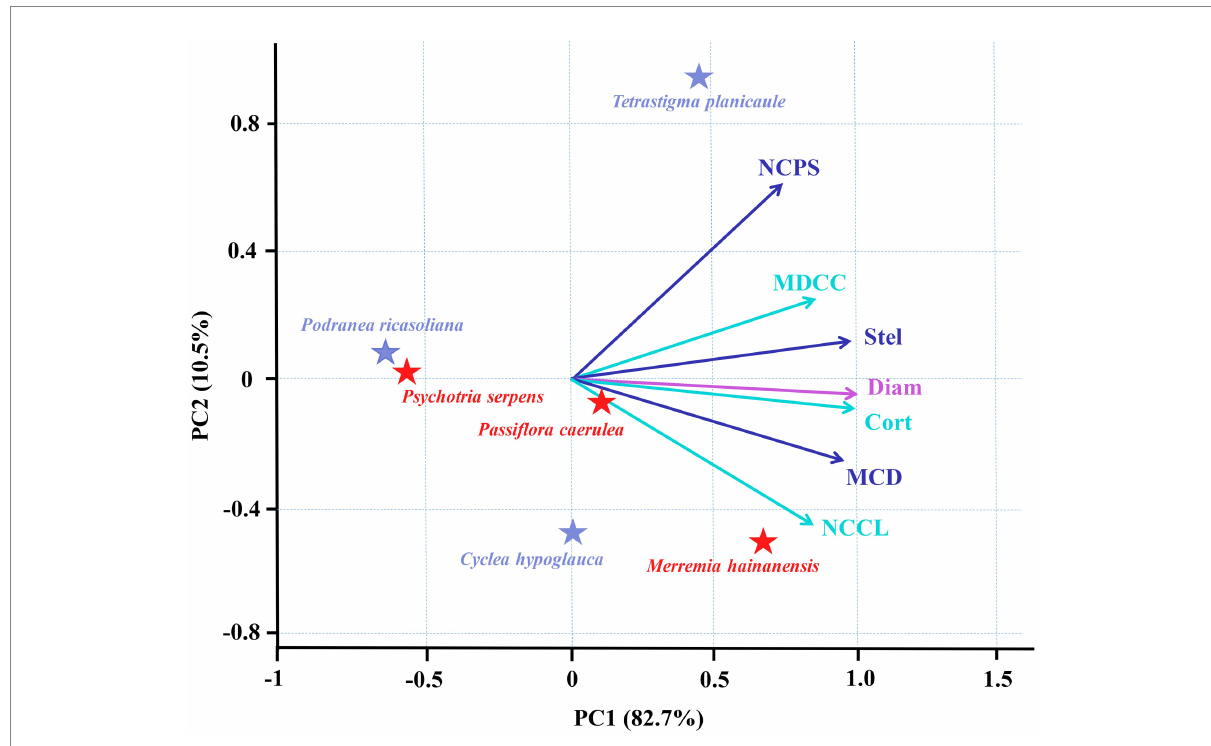
FIGURE 4 Principal component analyses (PCA) for root diameter and six anatomical traits of root tips in three vines (herbaceous climbing plants) and three lianas (woody climbing plants) in tropical forest ( n = 6). All the abbreviations are the same as those described in Figure